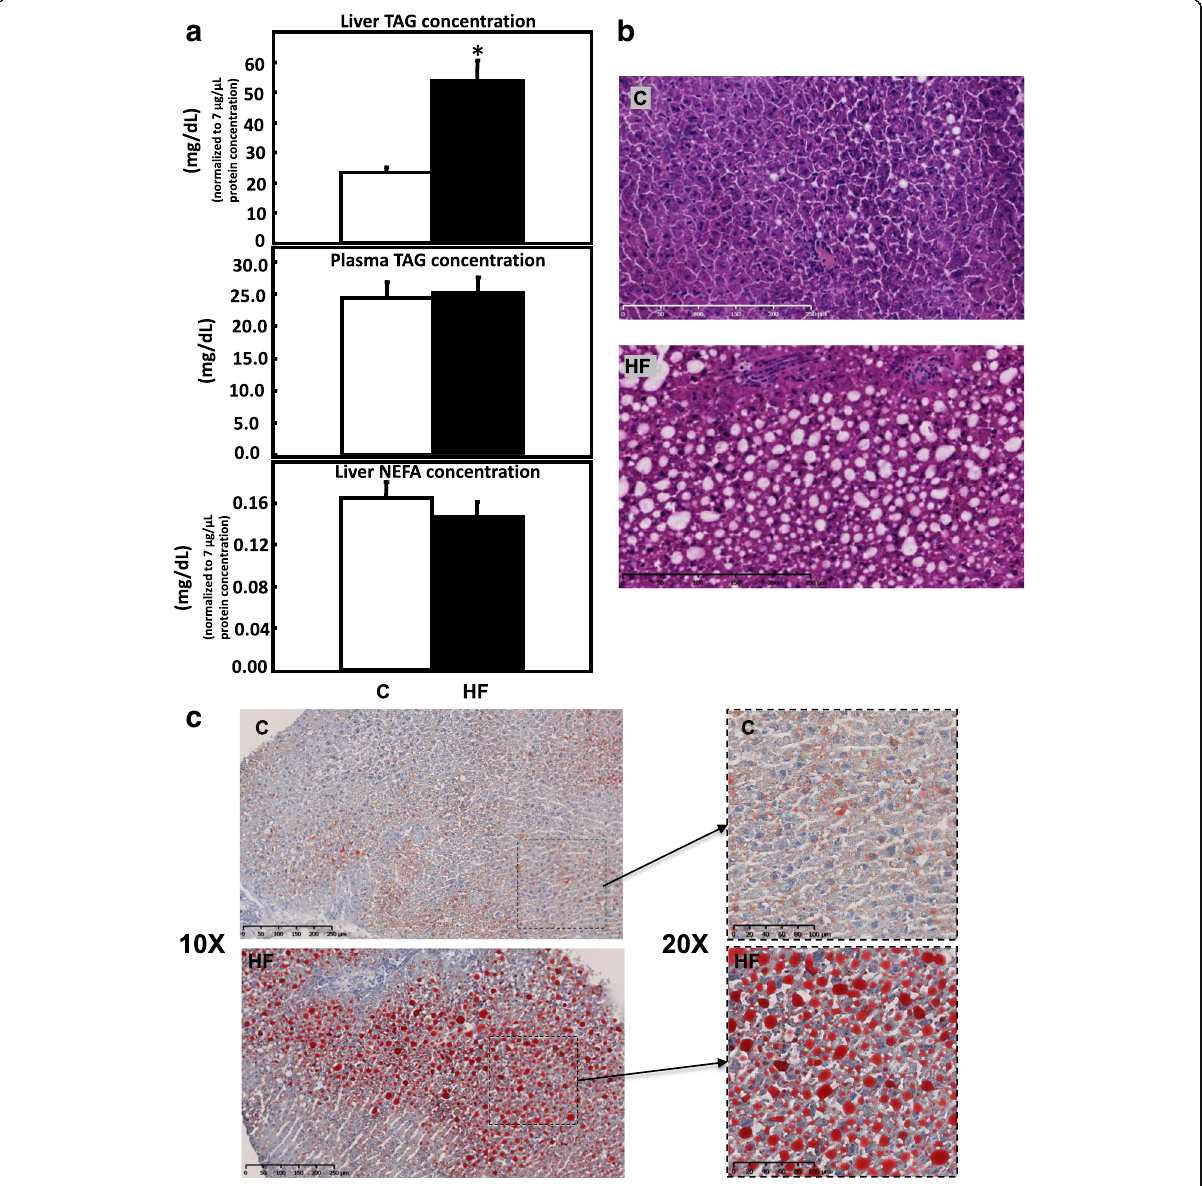
Fig. 2 Liver histological outcome rats fed HF and C diets. a Triglyceride (TAG) concentration in plasma and liver, non-esterified fatty acid (NEFA) concentration in the liver. Data are presented in arbitrary units as relative liver TAG or NEFA abundance normalized to protein abundance. Values are mean ± SEM, P < 0.05*. b H&E stain of representative liver sections (× 20). c ORO stain of representative liver sections (× 10 left and × 20